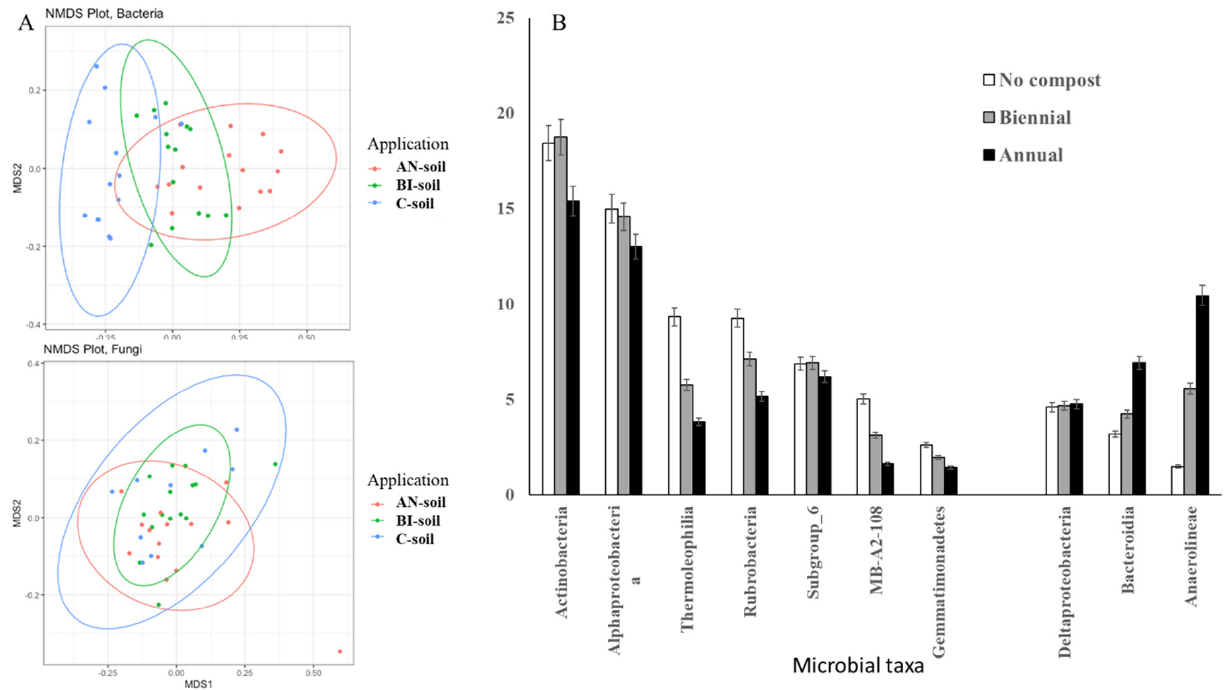
Figure 2. Diversity and structure of soils under different rates of compost application. ( A ): Non- metric multidimensional scaling plot of communities in soils under different rates of compost application. The analysis is based on Bray–Curtis distances of 16S rRNA ( top ) and ITS2 ( bottom ) samples. ( B ): Microbial taxa that were significantly overrepresented in comparison between soils with different rates of compost application. AN, BI, and C are annual, biennial and no compost (control) application, respectively. Corrected p -values ( q -values) were calculated based on Benjamini-Hochberg FDR multiple test correction. Features with (Welc’s t –test) q value < 0.01 were considered significant and were retained. Only microbial taxa represented by >2% total reads were shown at the class